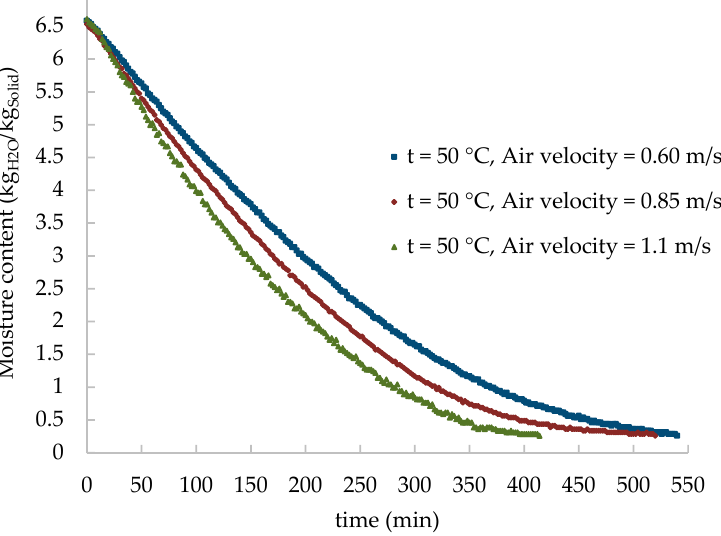
Figure 3. E ff ect of air velocity on dry basis moisture content Figure 3. Effect of air velocity on dry basis moisture content (X).